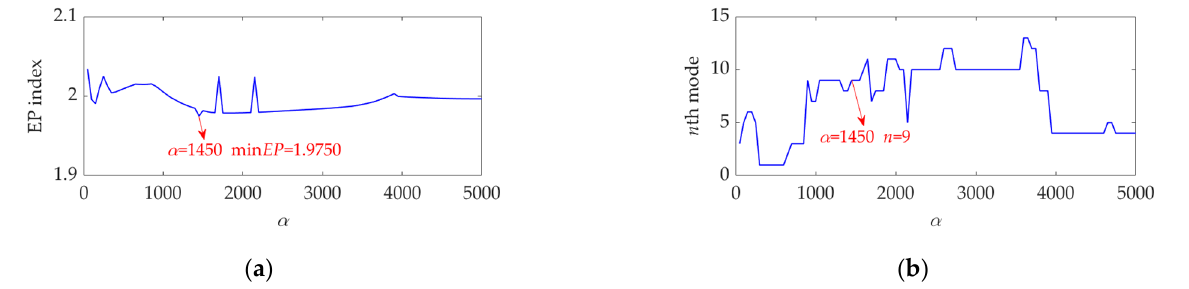
Figure 13. Results of the vibration dataset associated with the inner race fault obtained using SVMD with α opt = 1450.